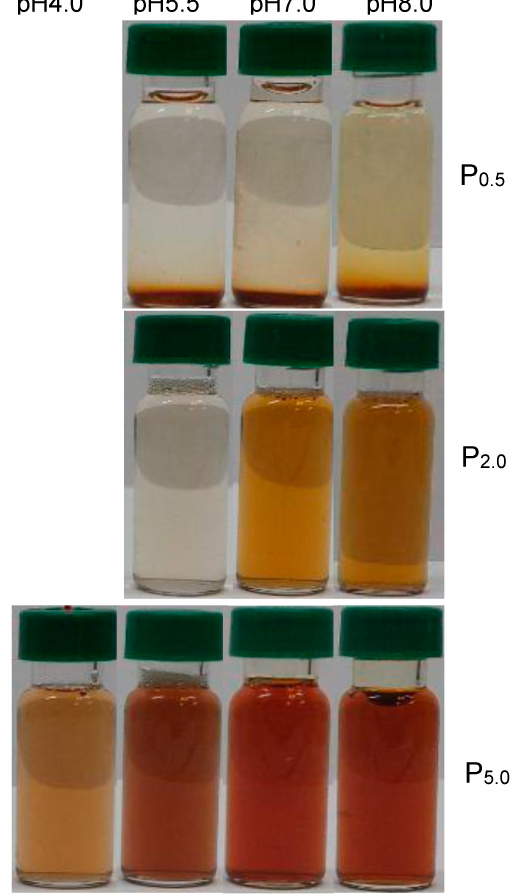
Figure 4. Photographs of EPS-AgNP dispersions at pH 4.0, pH 5.5, pH 7.0, and pH 8.0 after stored at room temperature for 2 months. (AgNP formation did not occur at pH = 4 for EPS fractions P 0.5 and P 2.0 ).